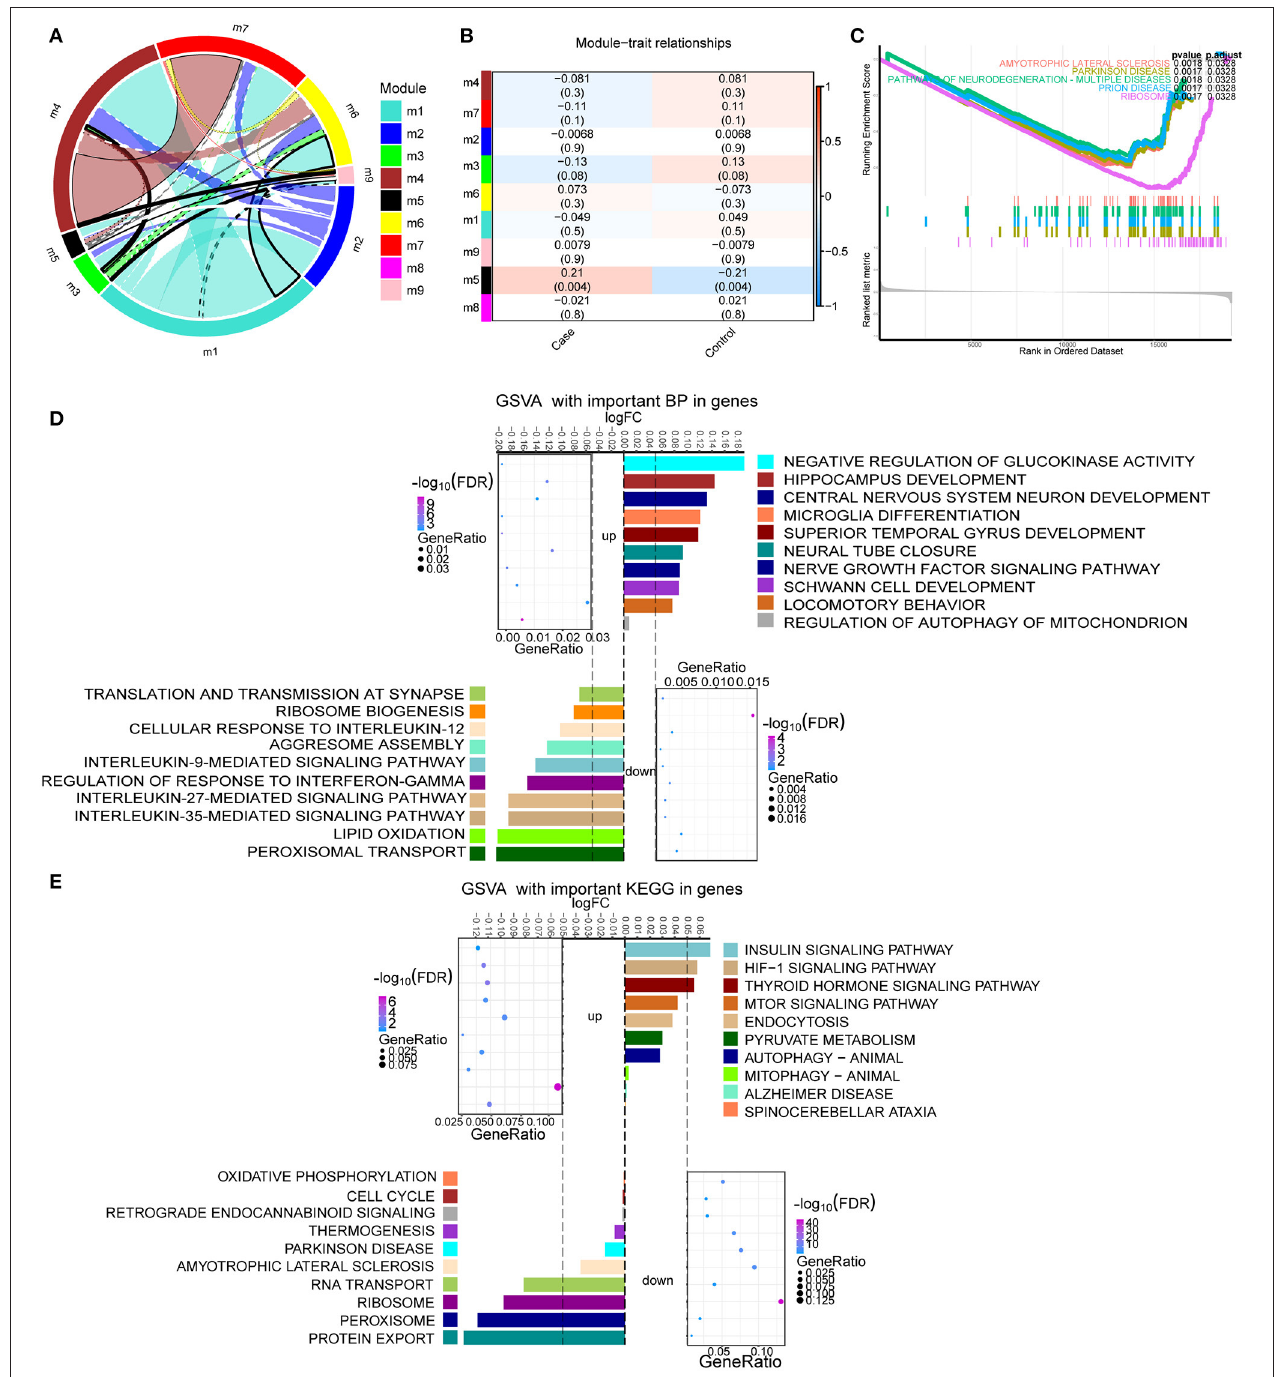
FIGURE 3 | Enrichment analysis of module genes with the most crosstalk. (A) Crosstalk between module genes. (B) The correlation between module and clinical trait. Red node represents up-regulation, and blue node represents down-regulation. (C) The same KEGG signaling pathway in GSEA results as enrichment results. Different colors represent different signaling pathways. (D) The up- or down-regulation of major biological processes in important modules calculated by GSVA. (E) The up- or down-regulation of the major KEGG pathway in important modules calculated by GSVA.